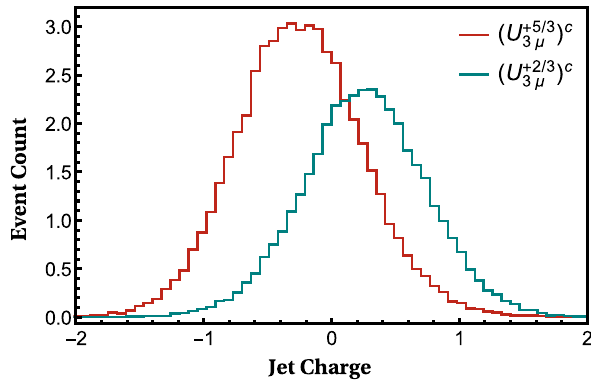
Fig. 13 Charge distribution (in the unit of e ) of c , s -jets coming from the vector triplet leptoquark decays